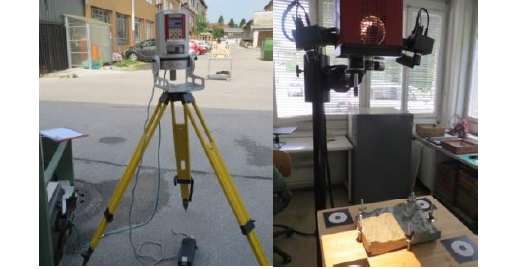
Fig. 1. The Riegl VZ400 (left) and GOM ATOS I (right) measurement set-ups